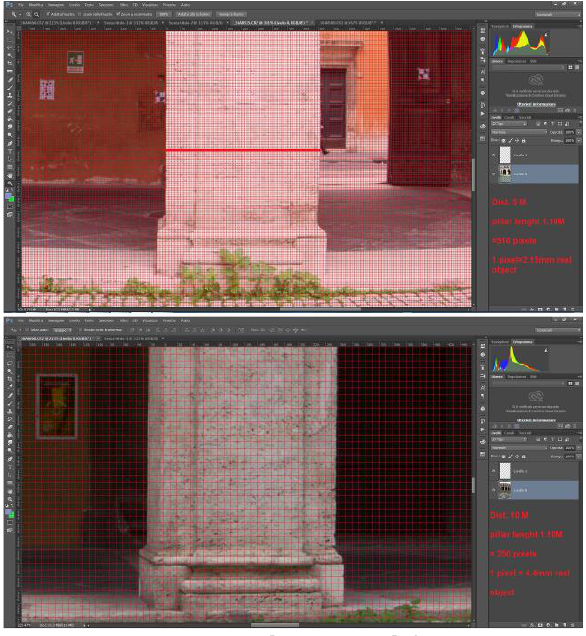
Figure 3. Image resolution VS real object size